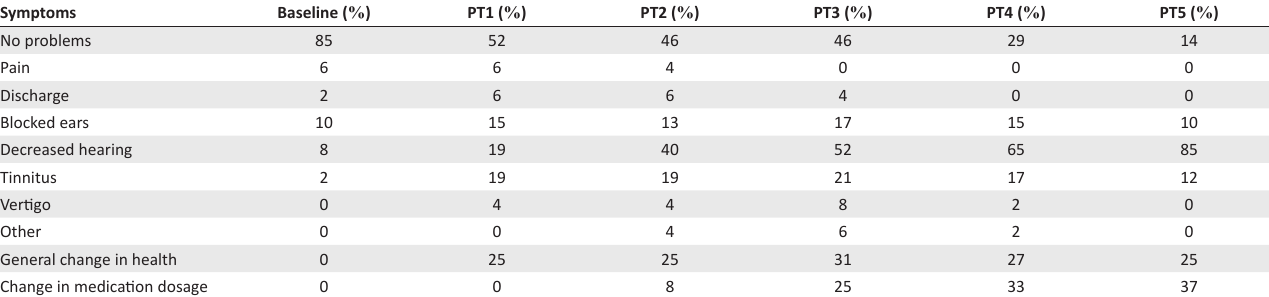
TABLE 3: Relevant case history findings over treatment duration.